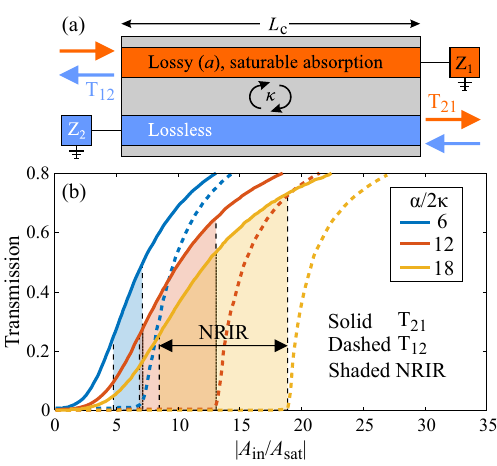
Figure 1. (a) Abstract two-port nonlinear asymmetric waveguide coupler of length L = L c = π/ 2 κ ; terminals Z 1 , 2 denote matched loads. (b) Forward ( T 21 ) and backward ( T 12 ) transmission vs. normalized input amplitude; colors correspond to di ff erent values of the loss parameter α/ 2 κ . Figure 2. Forward (solid) and backward (dashed) transmission for the graphene waveguide coupler with SA. Shaded region cor- responds to T 21 ≥ − 6 dB and T 12 ≤ − 15 dB. (Inset) Cross section (not to scale) of the silicon slot coupler with the symmetric su- permode. The arrow indicates the dominant mode